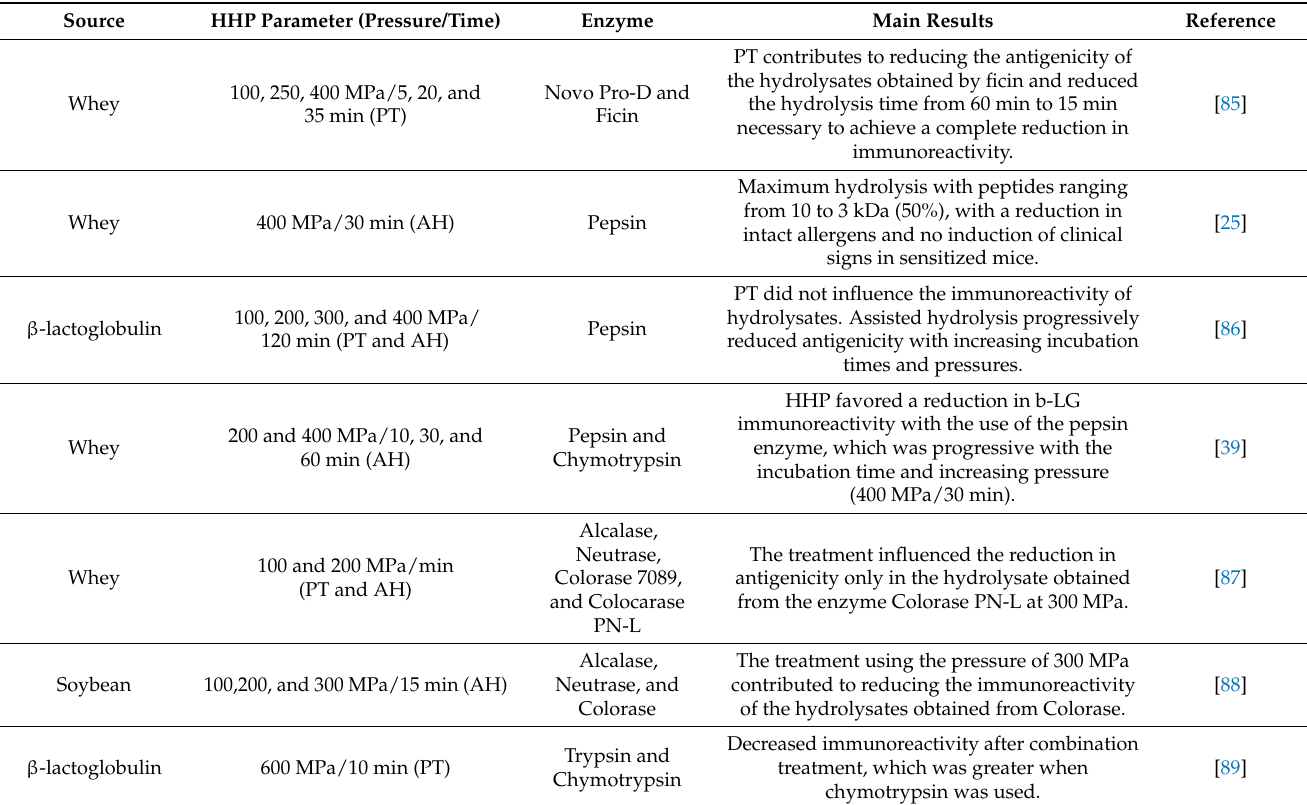
Table 3. Influence of HHP on the production of hydrolysates with reduced